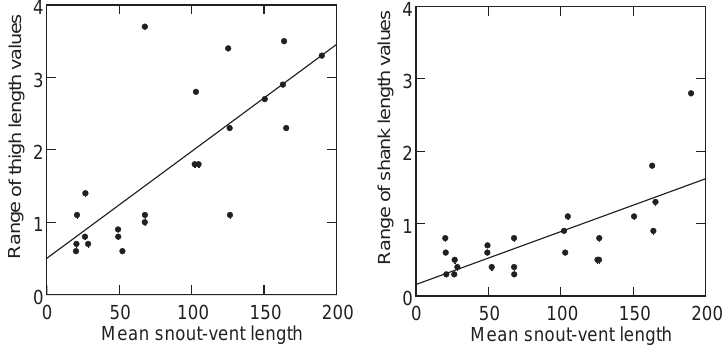
Fig. 4 – Comparison of magnitude of measurement errors for thigh length (left) and shank length (right). All values in